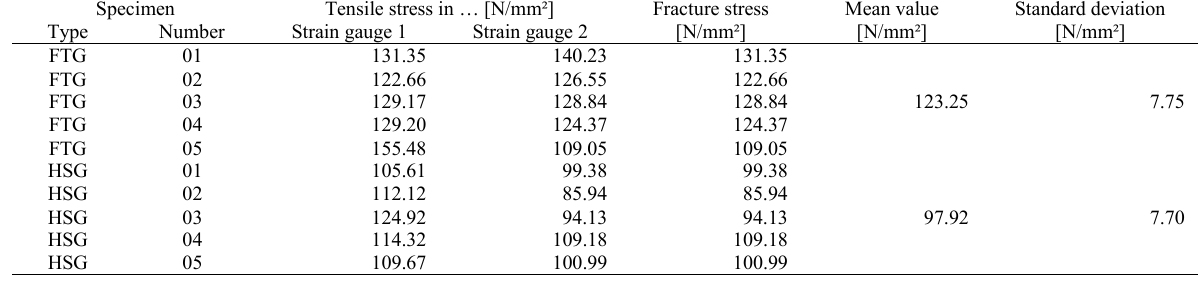
Table 5: Maximum tensile stresses of the destructive run of the reground specimens (3 mm).